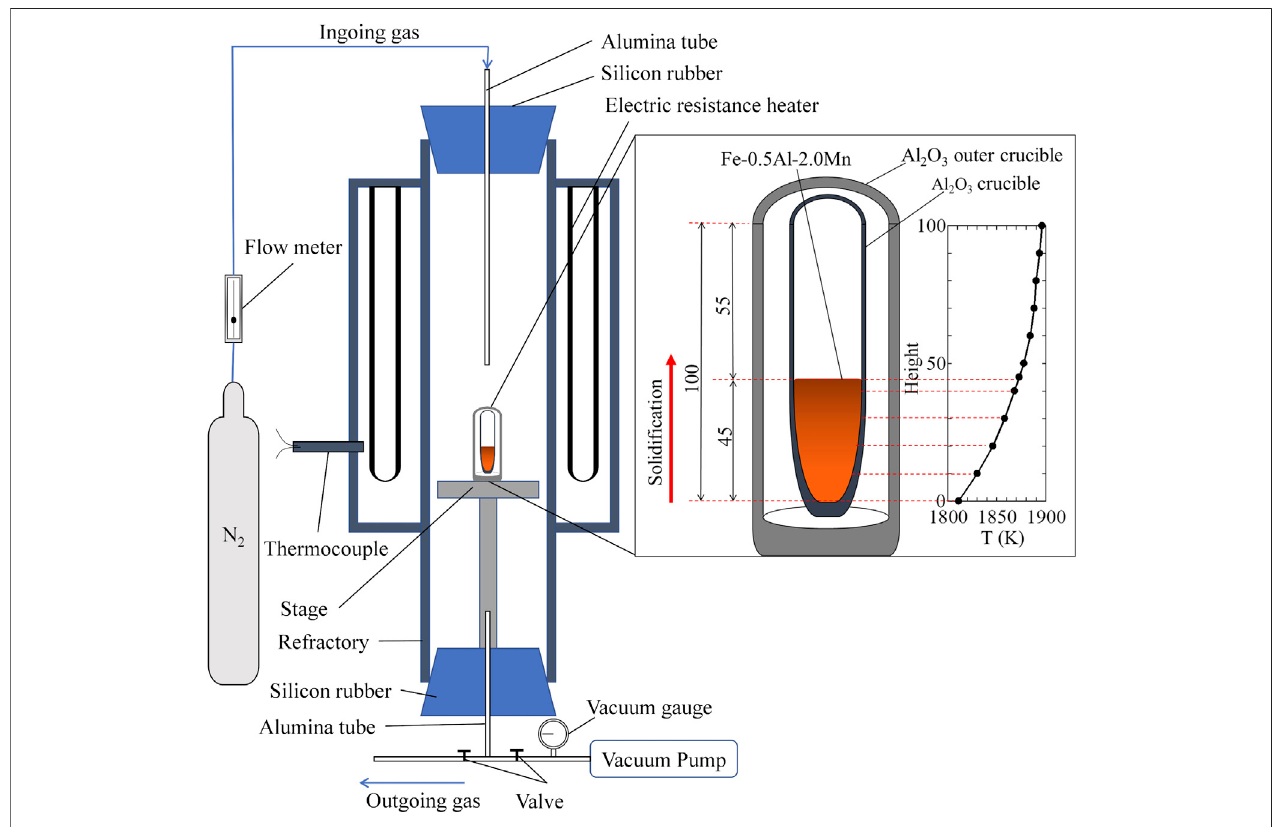
FIGURE 1 | A schematic diagram of the experimental apparatus.